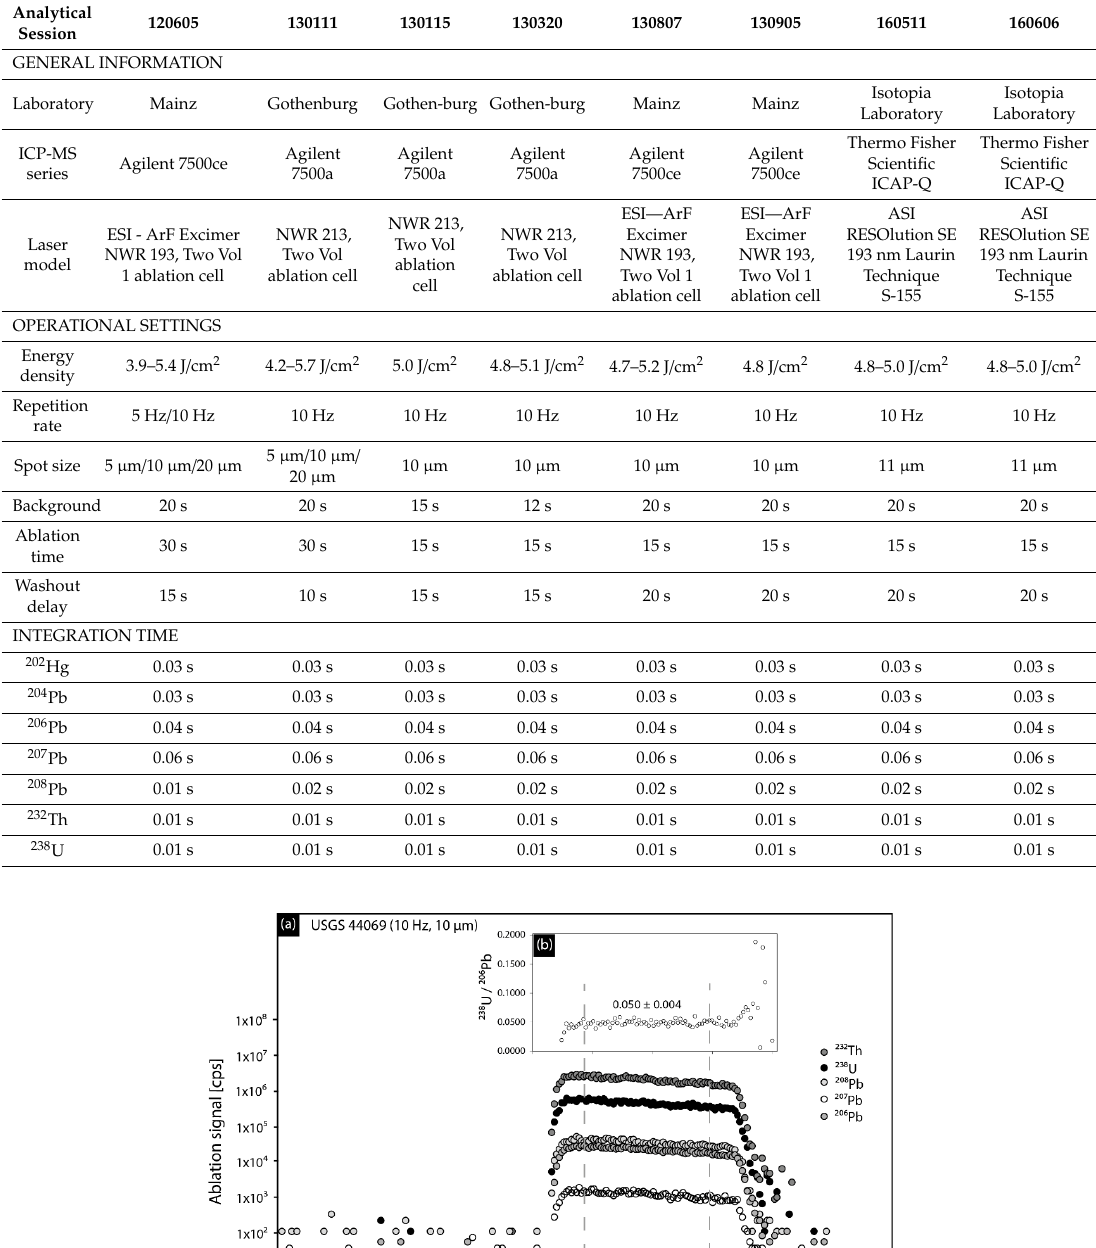
Table 2. Instrumental and operational settings for all eight analytical session.